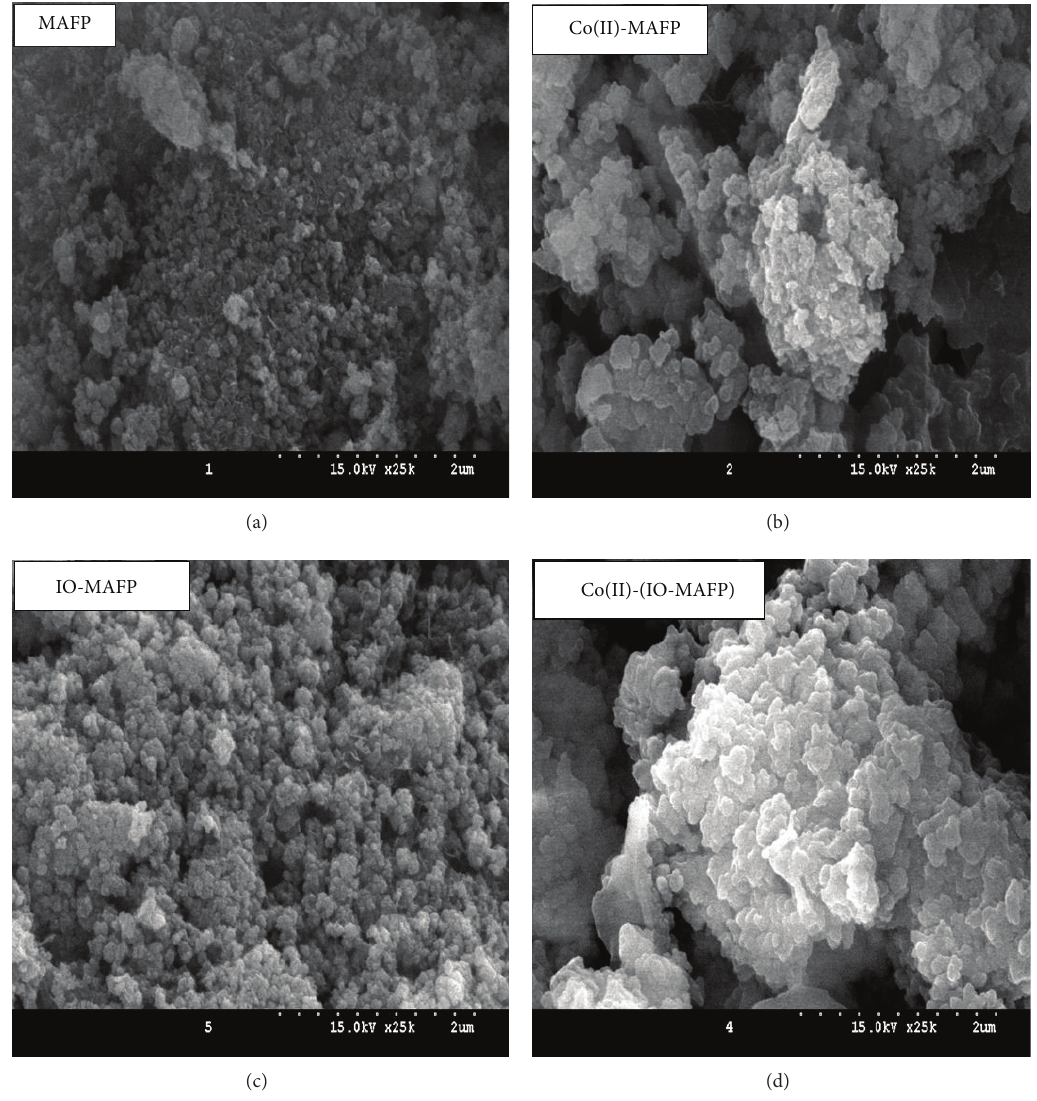
Figure 2: SEM images of MAFP and IO-MAFP before and after sorption Co(II).